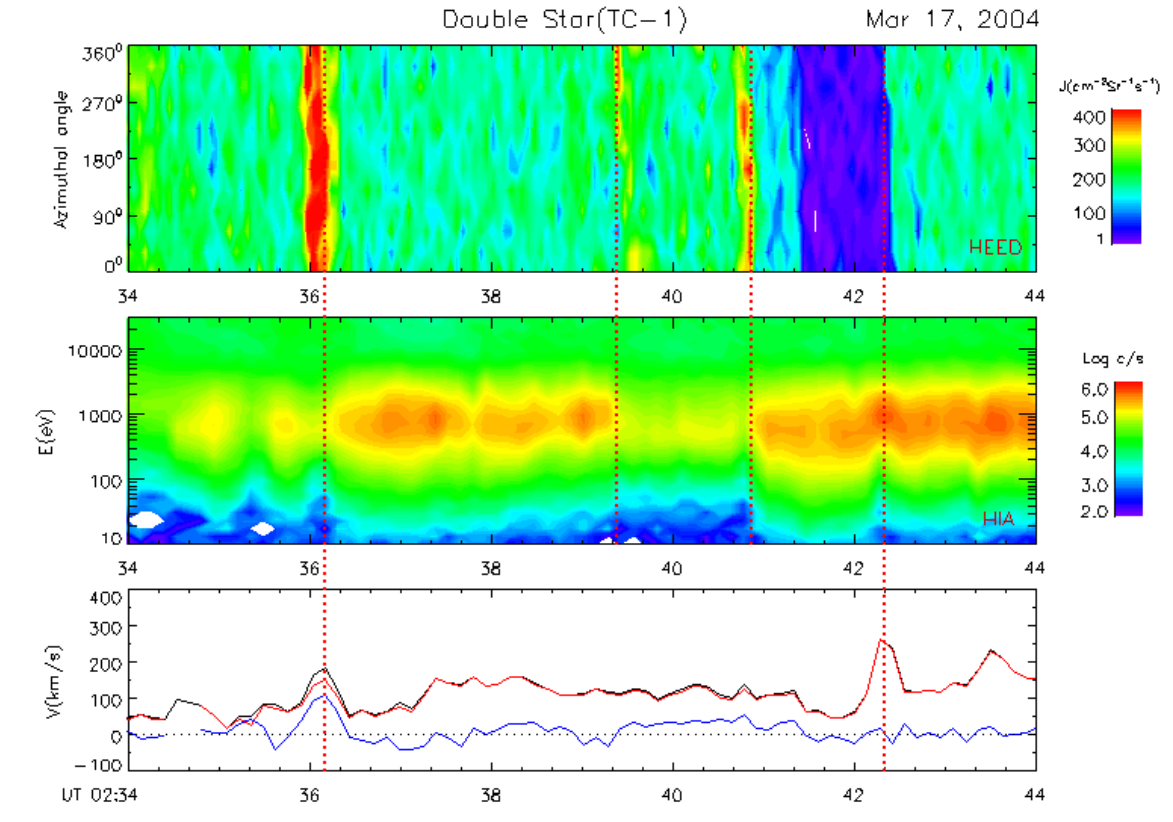
Fig. 6. (a) Time-energy spectrogram of electrons in the energy range of 0.2–0.4MeV recorded by the HEED experiment onboard the TC-1 spacecraft. The vertical axis is the azimuthal angle, which is defined in the plane perpendicular to the satellite spin axis. (b) HIA time-energy spectrogram. (c) Ion bulk velocities: the black curve represents the total velocity, and the blue and red represent parallel and perpendicular velocities,